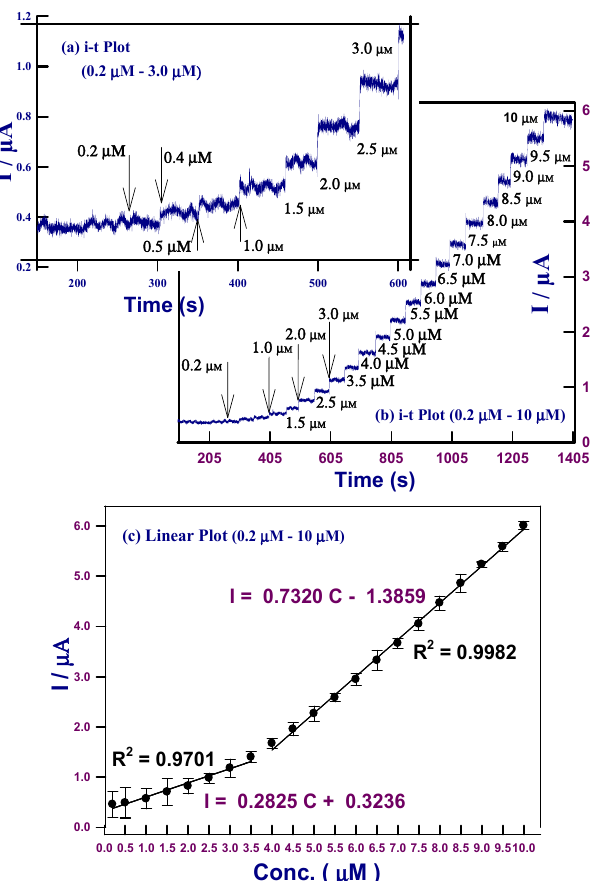
Figure 7. Amperometry i–t curve of a HCNiO/GC electrode in different concentrations of glucose in 0.05 M NaOH at E = 0.52 V; ( a ) i–t plot of 0.2 to 3 µM glucose; ( b ) i–t plot of 0.2 to 10 µM glucose; and ( c ) lnearity plot of 0.2 µM to 10 µM glucose. The mean peak current ( n = 3) at the relevant concentration is shown with error bars equal to three standard deviation (3 σ ).